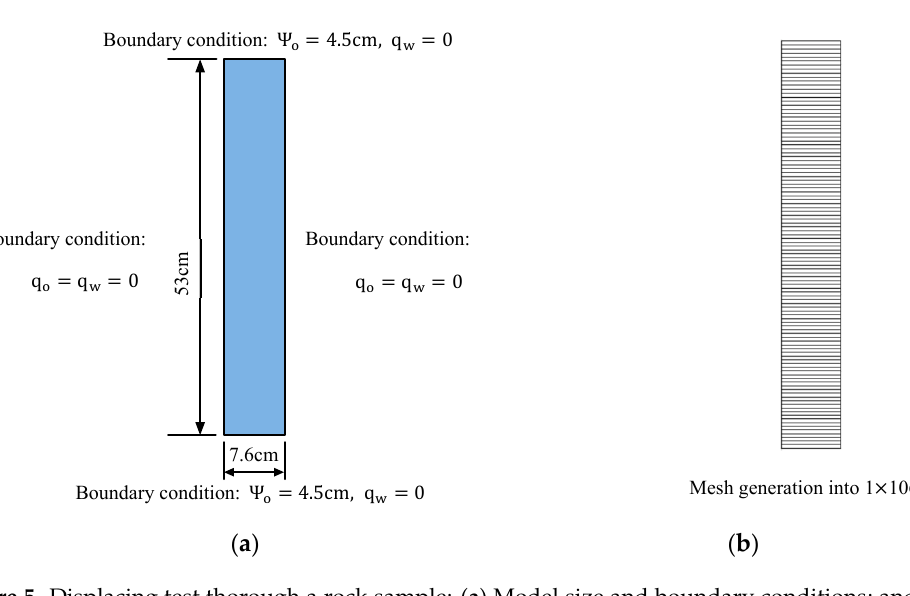
Figure 5. Displacing test thorough a rock sample: ( a ) Model size and boundary conditions; and ( b ) model meshing.